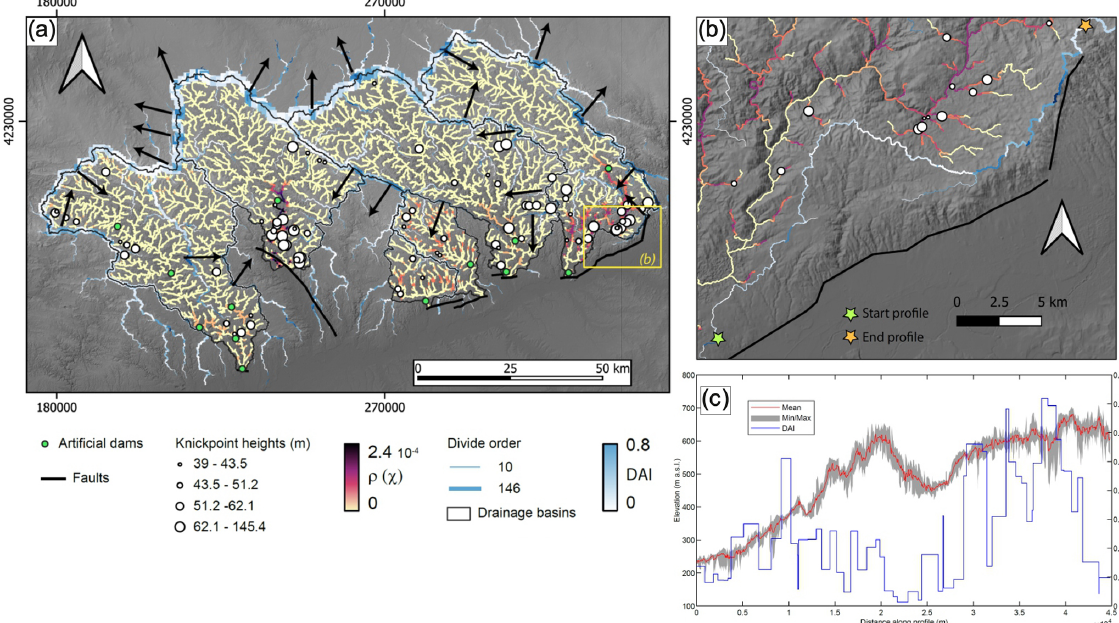
Figure 11. (a) Observed and expected spatial patterns of knickpoints in the selected Sierra Morena basins. The intensity ( ρ ) values are computed on the knickpoint dataset without artificial dams. The drainage divide network asymmetry (DAI) sized by order is reported, and the inferred movement is indicated by the black arrows. The elevation base is the 12m resolution TanDEM-X DEM (Wessel, 2016). The reference system is WGS 84/UTM zone 30N. (b) Detail of panel (a) with ( ρ ) and DAI values of S6 in the sector of the capture elbow. (c) Along-divide swath profile with a width of 1000m and corresponding DAI values (note the presence of wind gaps along the SE